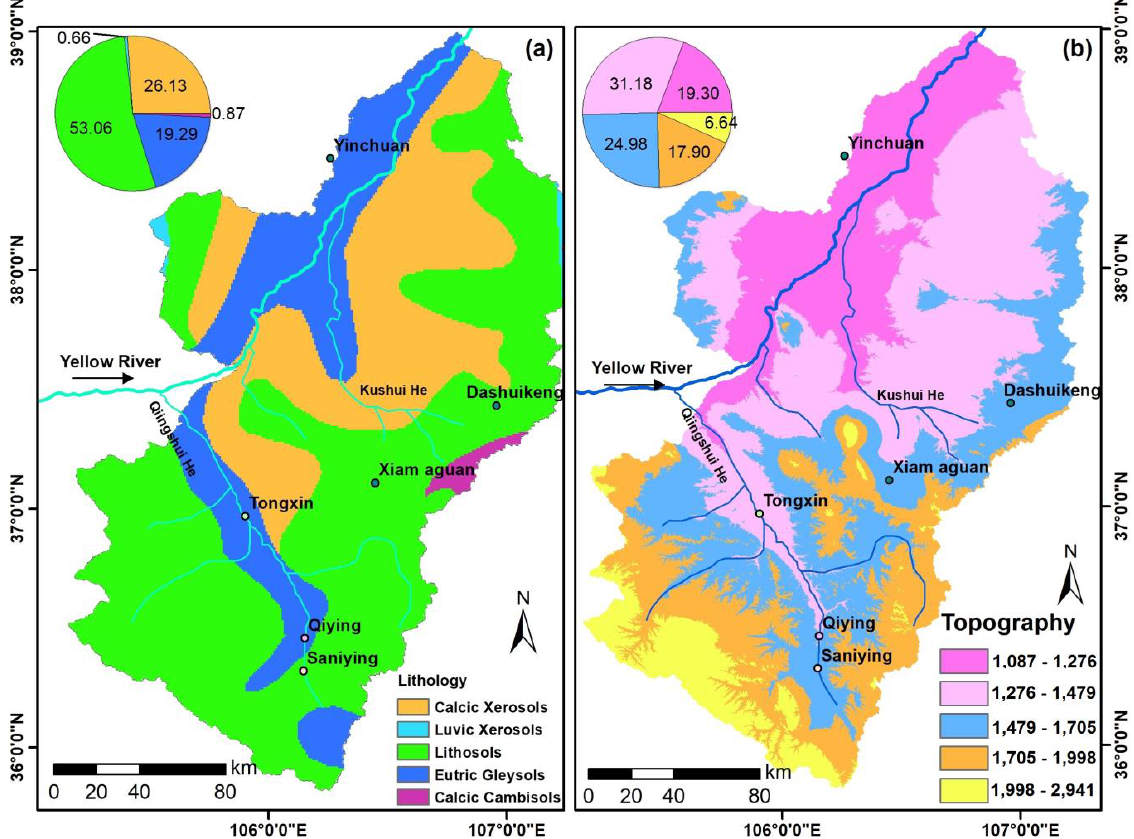
Figure 3. ( a ) Soil map of the study area; ( b ) Digital elevation model (DEM) data of the present study displays the variations in elevation.